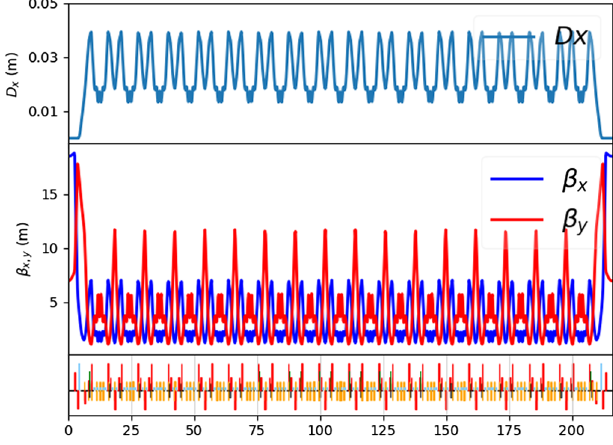
FIG. 4. Optical functions in the arc (octant) without the undulator insertions.